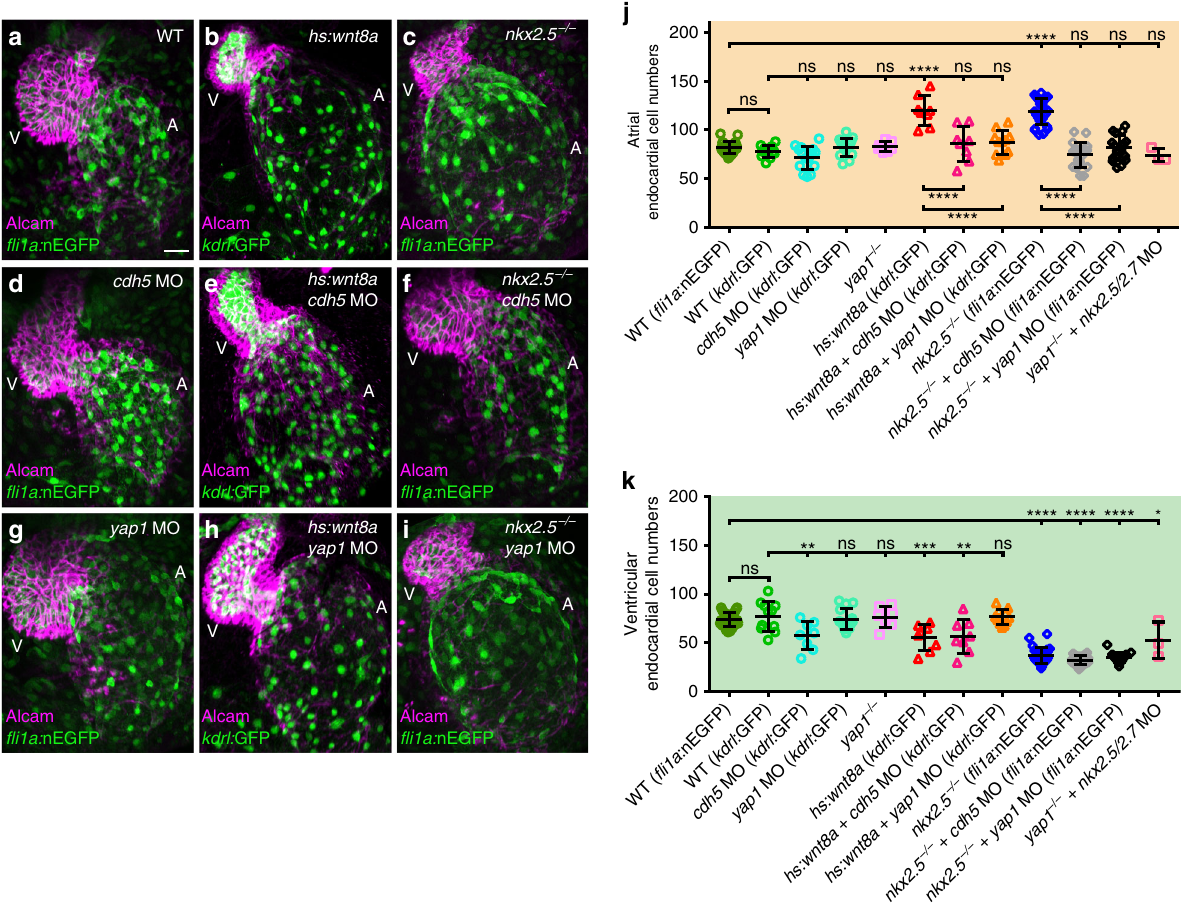
Fig. 5 Loss of Cadherin-5 or Yap1 prevents endocardial cell number increases during atrial chamber expansion. a – i Reconstructions of confocal z-stacks of zebra fi sh hearts at 52 hpf expressing the endocardial reporter Tg(kdrl:EGFP) s843 or Tg( fl i1a:nEGFP) y7 (green) and immunolabeling against the myocardial marker Alcam (magenta). j Quanti fi cations of endocardial cell numbers at 52 hpf. b , j Upon Wnt8a overexpression ( n = 7 hearts), atrial endocardial cell numbers increase. c , j Similarly, in nkx2 . 5 vu179 mutants ( n = 27 hearts), endocardial cell numbers increase within the atrium. d , j MO-mediated knock down of Cadherin-5 (Cdh5) ( n = 7 hearts) does not cause a reduction of endocardial cell numbers within the atrium. e , j Loss of Cdh5 prevents increased atrial endocardial cell numbers upon overexpression of Wnt8a ( n = 8 hearts). f , j Loss of Cdh5 suppresses increased atrial endocardial cell numbers in nkx2 . 5 vu179 mutants ( n = 19 hearts). g , j Loss of Yap1 via MO-mediated knock down ( n = 14 hearts) or in yap1 fu48 mutants ( j , k ) does not affect ventricular or atrial endocardial cell numbers. h , j Knock down of Yap1 in Wnt8a overexpressing embryos normalizes ventricular and atrial endocardial cell numbers